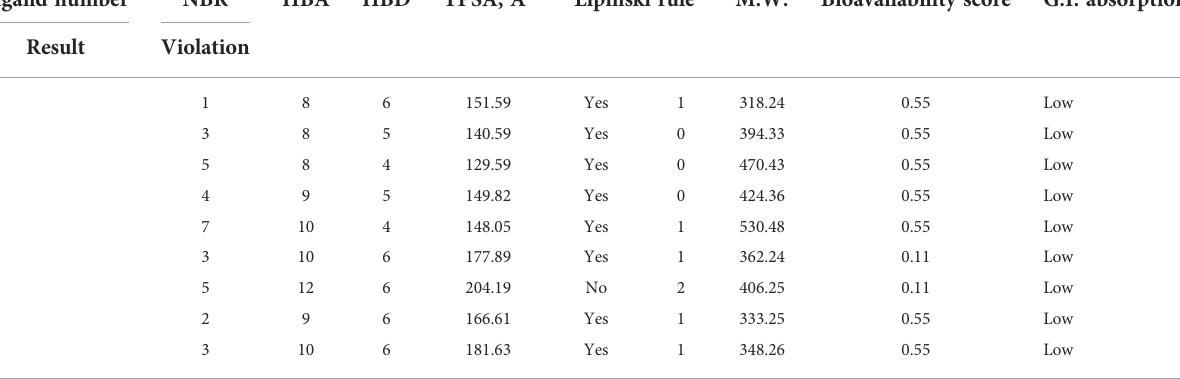
TABLE 2 Data on Lipinski rule, pharmacokinetics, and drug-likeness. Ligand number